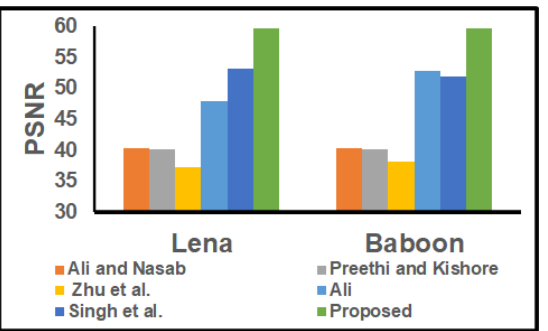
Figure 11. PSNR comparison of our method against state-of-the-art methods for Lena and Baboon images.